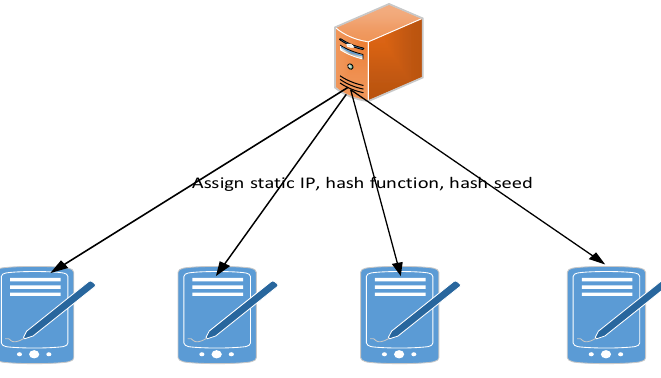
Figure 6. Initialization configuration.